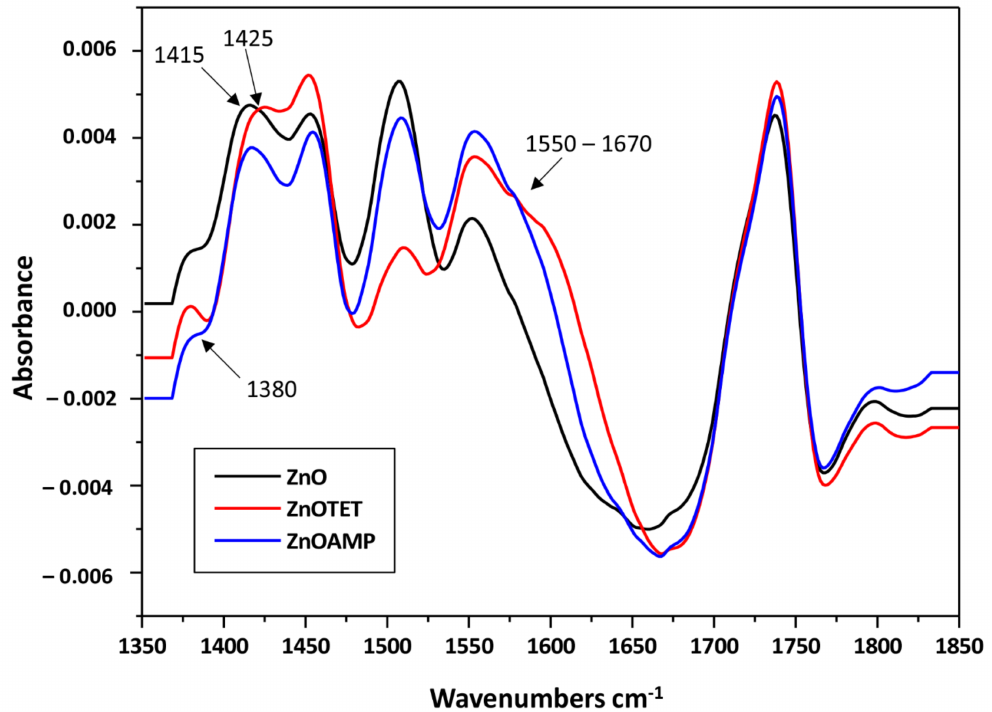
Figure 4. FTIR spectra of non-immobilized and immobilized ZnONPs.